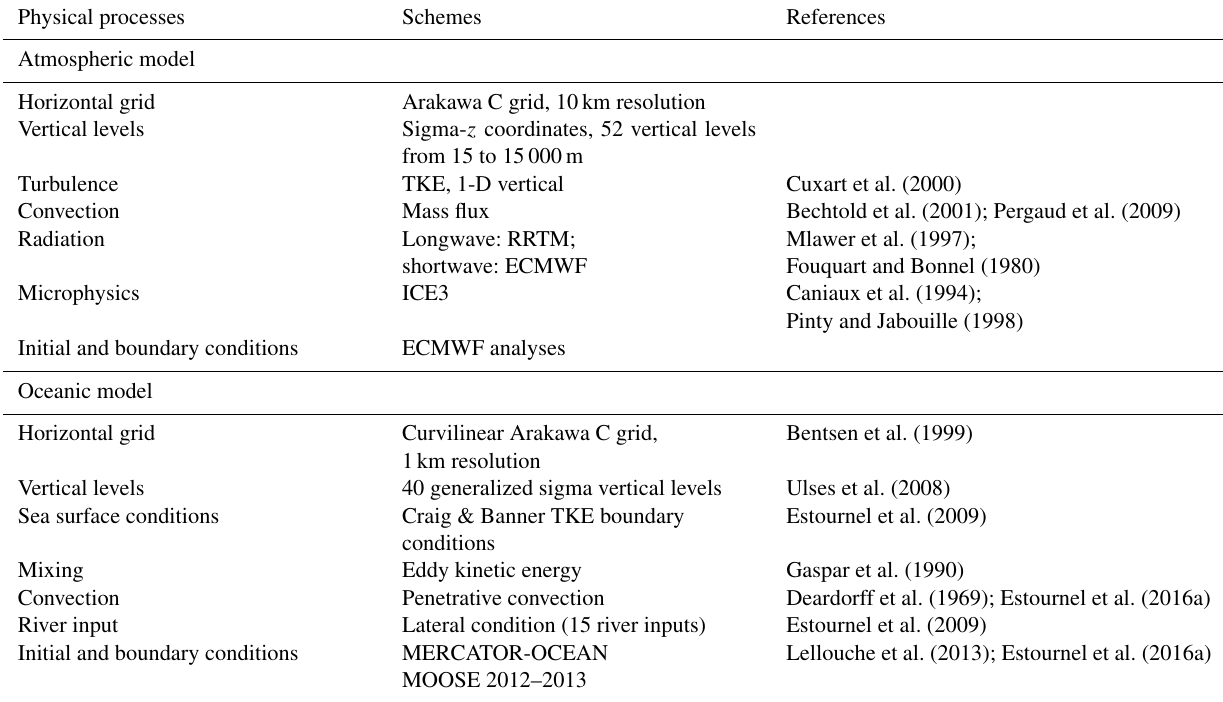
Table 1. Main characteristics of the atmospheric and oceanic model